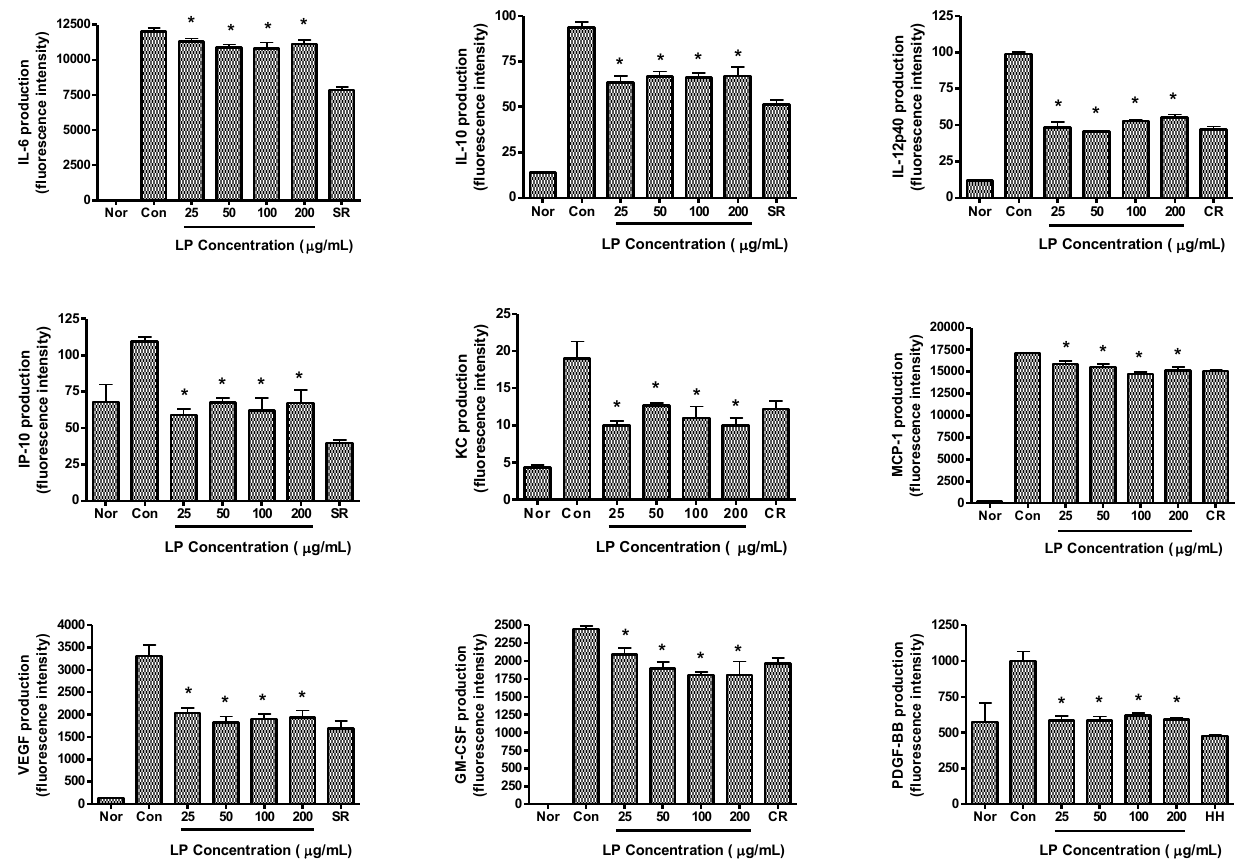
Figure 3. Effects of LP on cytokine production ( i.e. , IL-6, IL-10, IL-12p40, IP-10, KC, MCP-1, VEGF, GM-CSF and PDGF-BB) in LPS-stimulated RAW 264.7 macrophages. Fluorescence intensity (FI) of various proinflammatory mediators in the culture medium was measured by Multiplex bead-based cytokine assay after 24 h incubation. Normal group (Nor) was treated with medium only. Control group (Con) was treated with LPS (1 μg/mL) alone. As reference materials, water extracts of Scutellariae Radix (SR; 100 μg/mL), Coptidis Rhizoma (CR; 12.5 μg/mL) and Houttuyniae Herba (HH; 25 μg/mL) were treated with LPS for 24 h. Values are the mean ± SEM of three independent experiments. * p < 0.05 vs. Con.